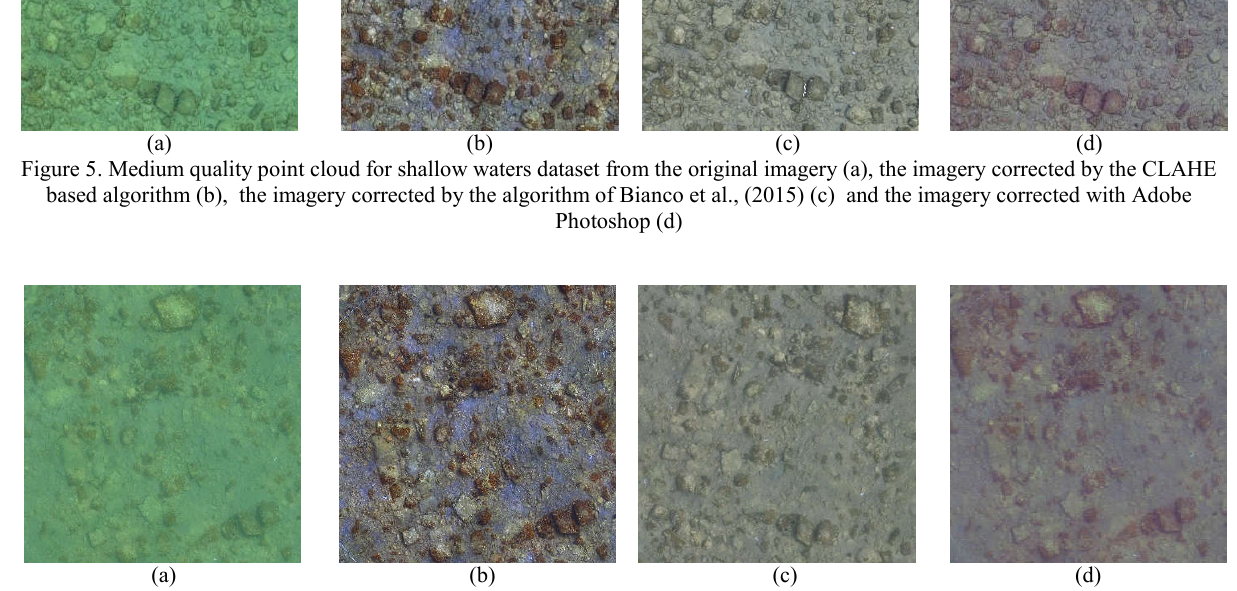
Figure 6. The orthoimage of the shallow dataset created by using the original images (a), by using the imagery corrected by the CLAHE based algorithm (b), by using the imagery corrected by the algorithm of Bianco et al., (2015) (c) and by using the imagery